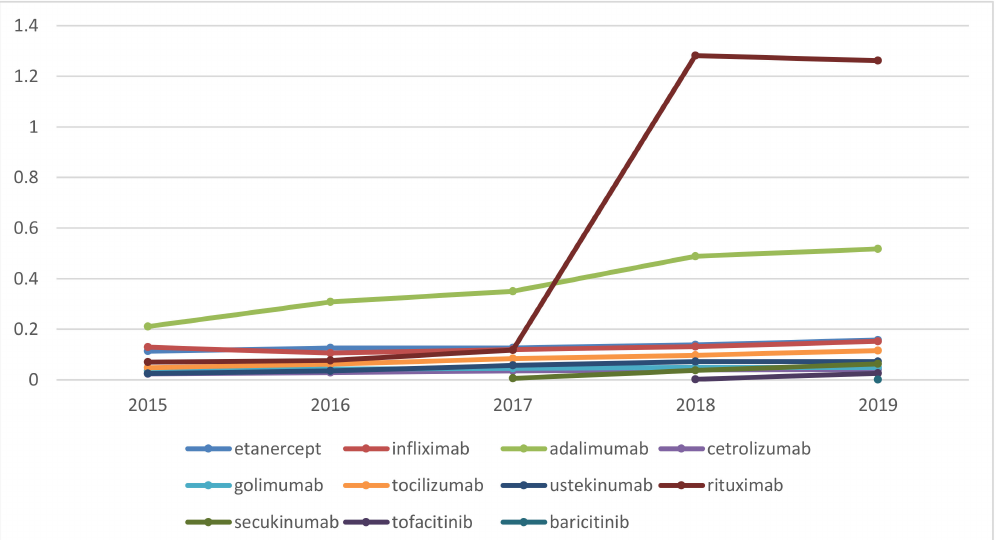
Figure 2. Utilization in DDD/1000inh/day.